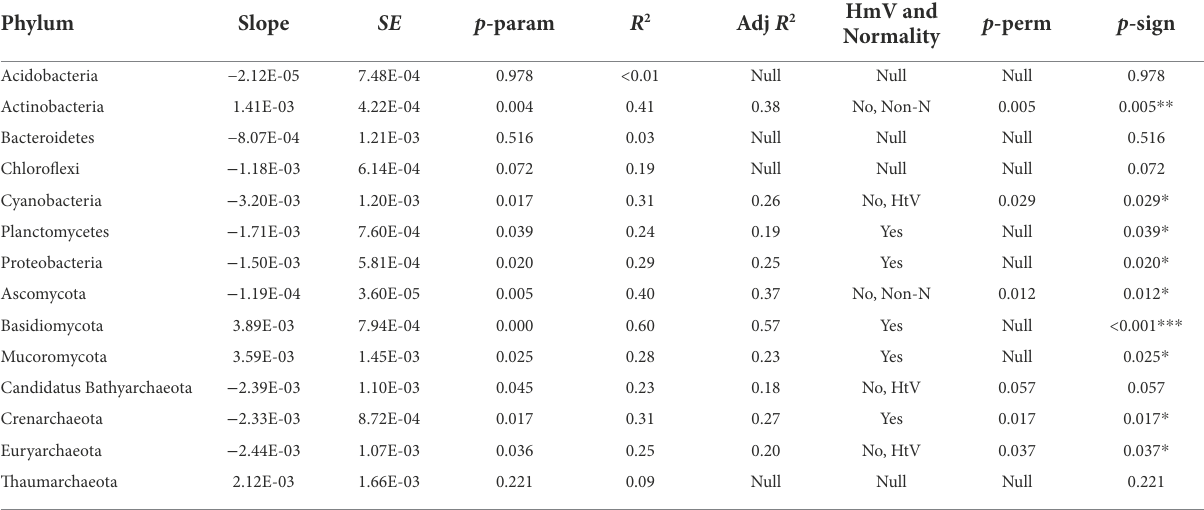
TABLE 1 The variations of phyla of bacteria, fungi, and archaea over different weathering times (average relative abundance >1%). Phylum